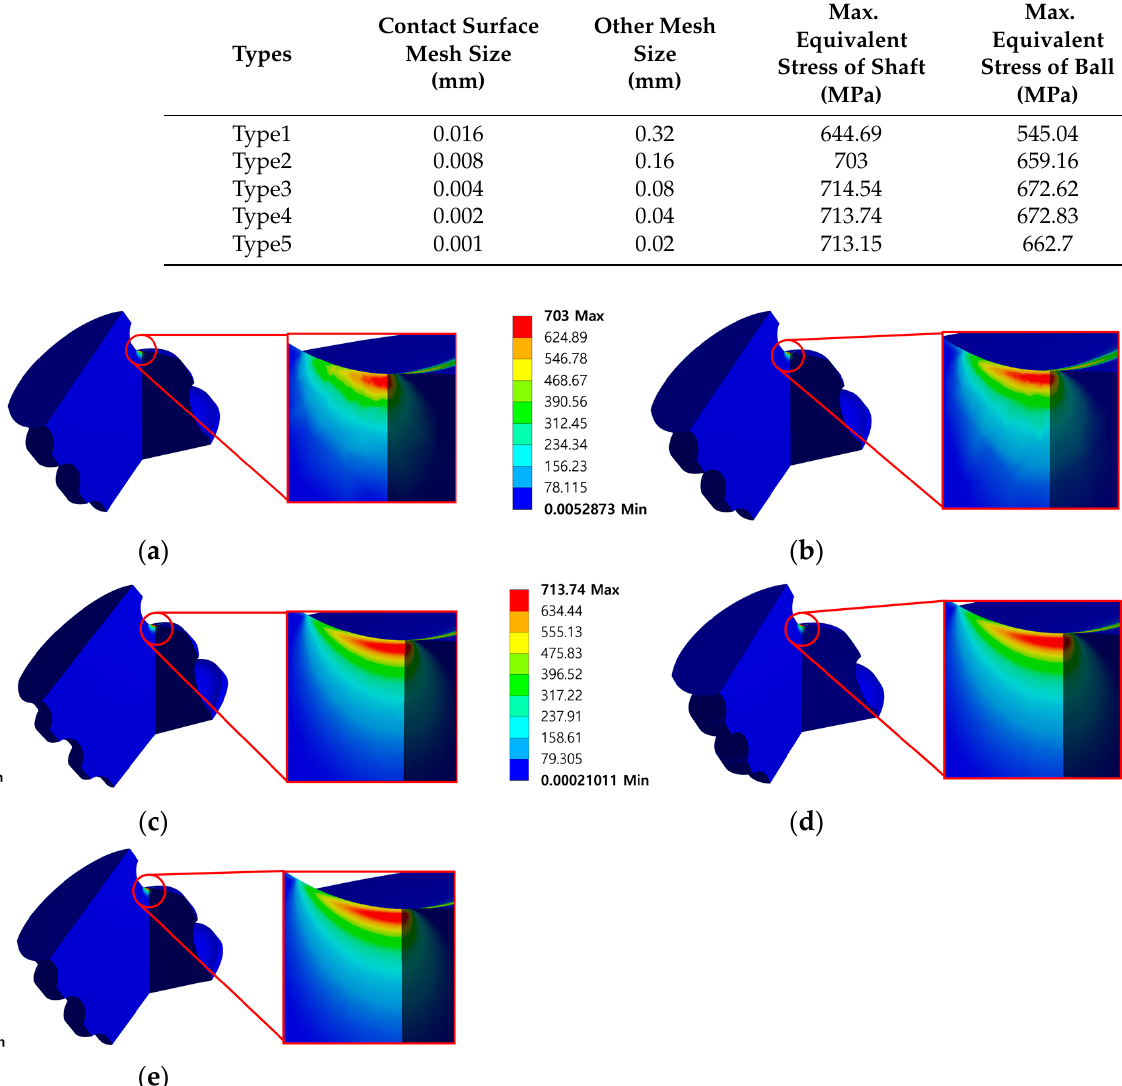
Table 5. Results of mesh dependency test.